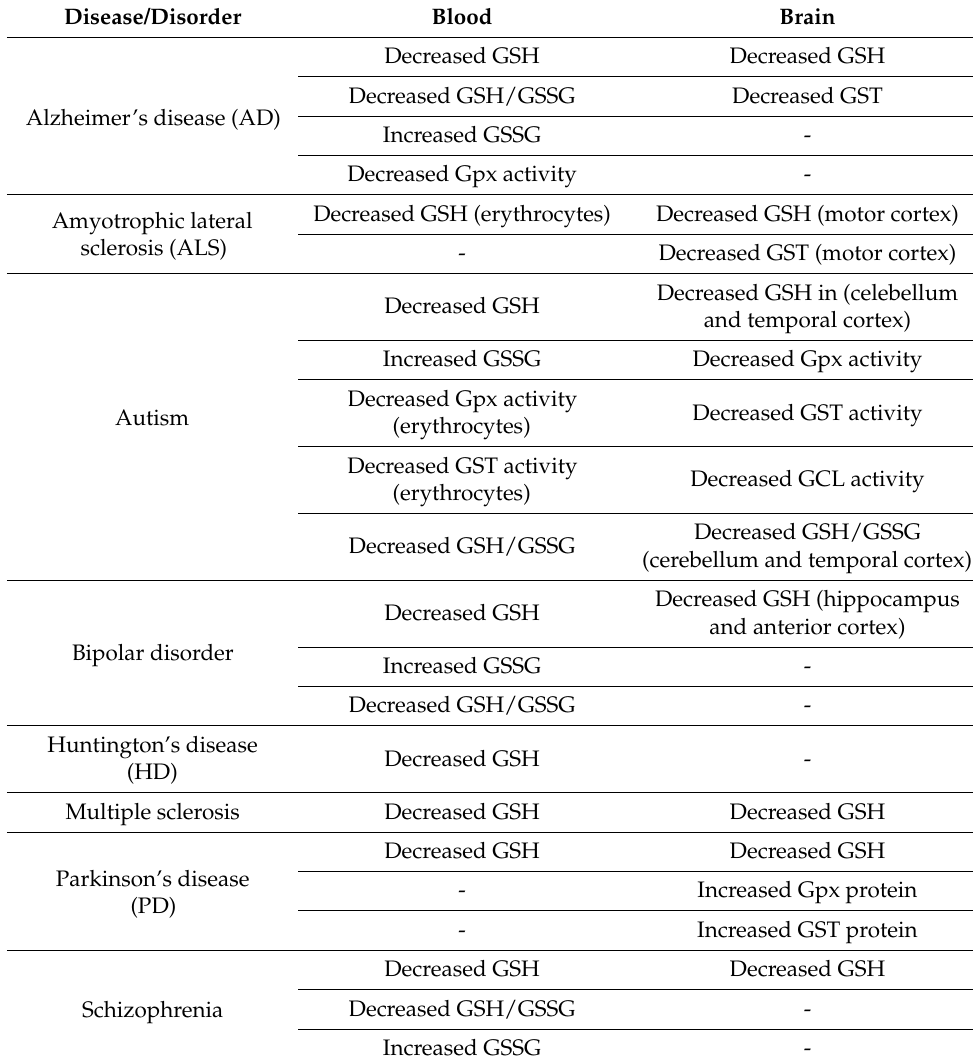
Table 2. Activity of glutathione-related enzymes and content of glutathione in the blood and brain of patients with different brain diseases